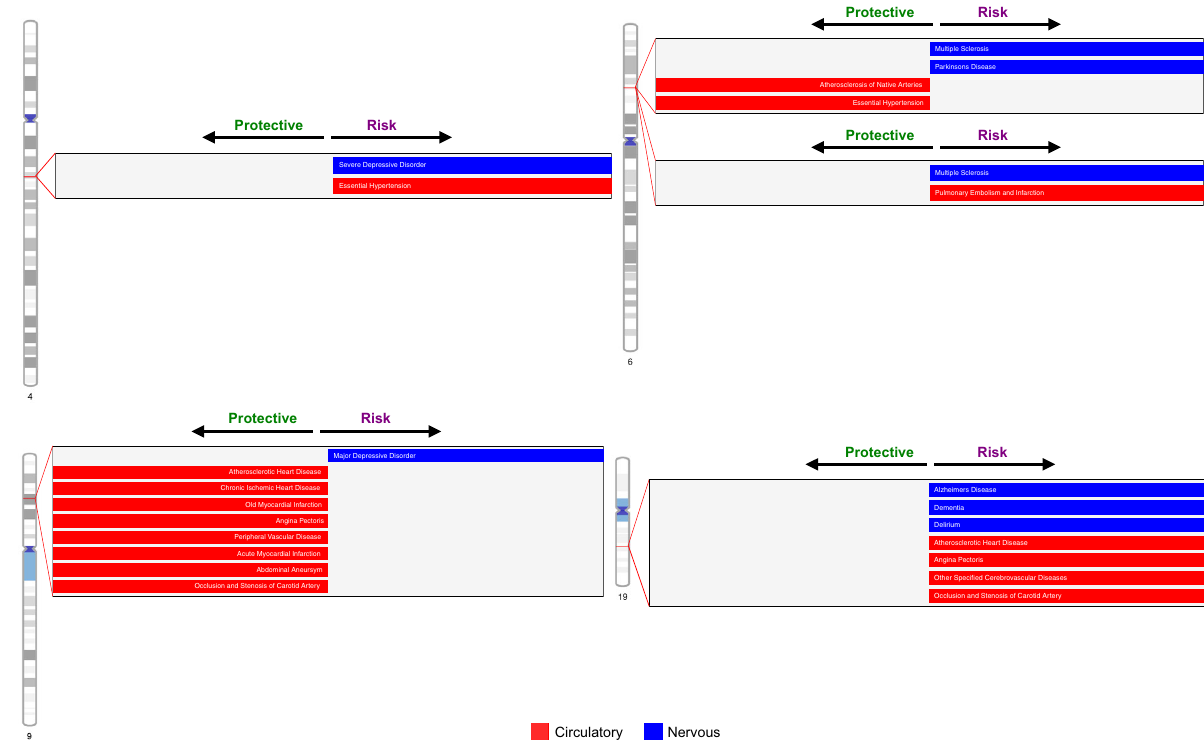
Fig. 4 Characterization of top associated diseases for identi fi ed pleiotropy. The diseases are characterized by sequential multivariate analyses and the direction of genetic effect is obtained from PheWAS results. The direction of genetic effect is based on the tested allele in our study. More details are shown in Supplementary Data 3. Note that the direction of genetic effect on chromosome 9 is a mixture of risk and protective effect for our tested alleles on two disease categories but overall opposite